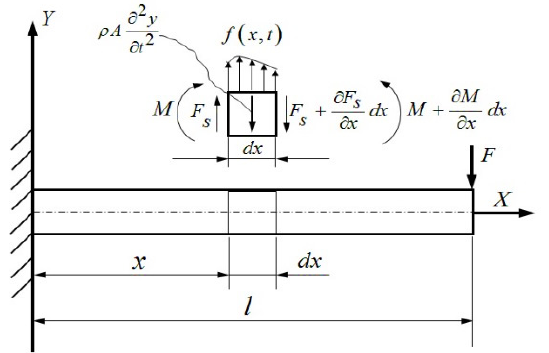
Figure 2. The dynamic model of the boring bar with Euler- Bernoulli beam element